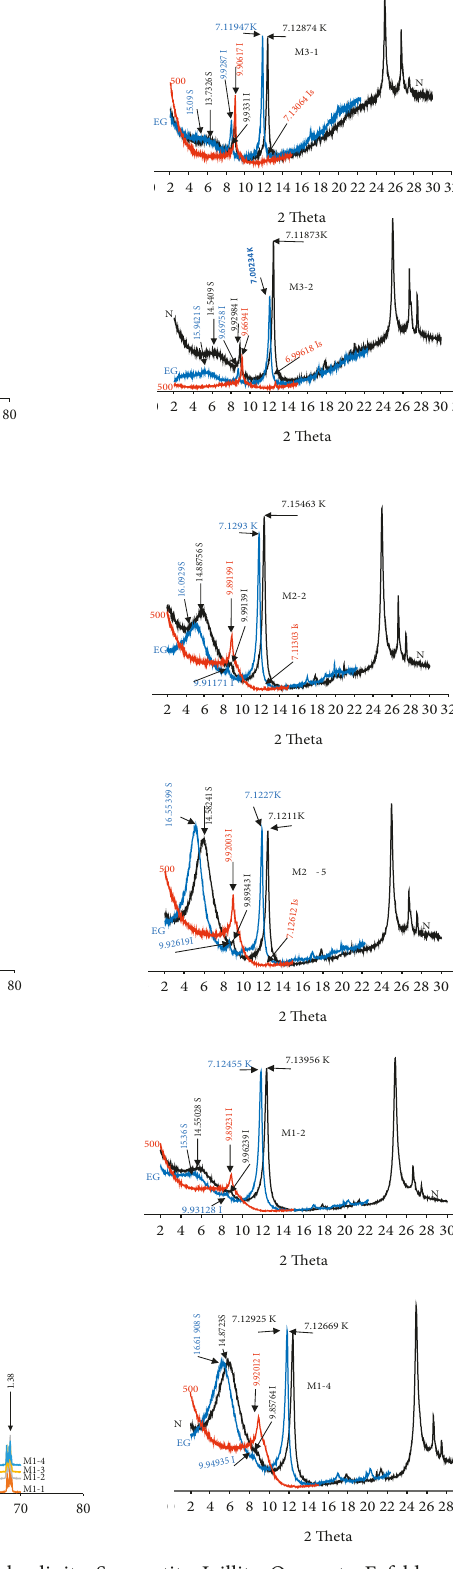
Figure 3: XRD patterns of samples bulk samples and clay fraction (K: kaolinite; S: smectite; I: illite; Q: quartz; F: feldspar; P: plagioclase; Is: interstratified clay mineral; N: air dried condition; EG: glycolated condition with ethylene glycol; H: heated at condition at 500 °